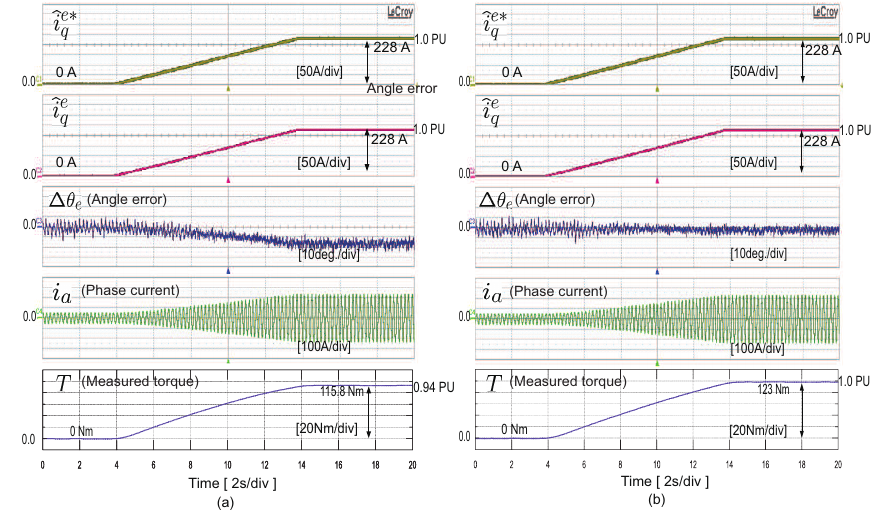
Figure 16. Field current injection method ( a ) without compensation for η caused by cross-coupling and ( b ) with compensation for η : ramp q -axis command (0 A → 228 A), q -axis current response, angle error, phase current, and